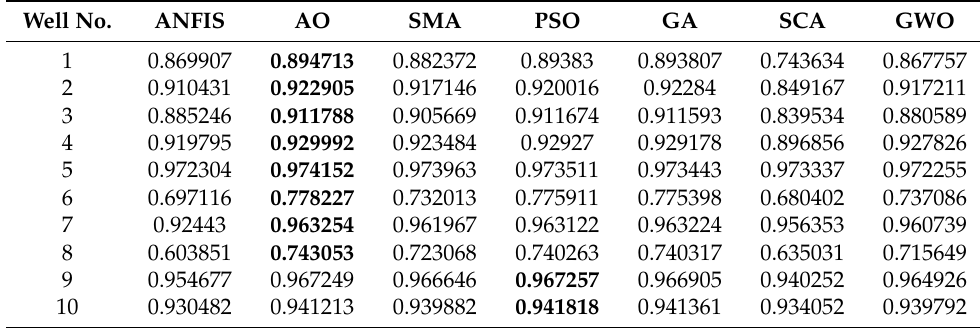
Table 5. The results of the Tahe oilfield, China, in terms of R 2 . The best values are shown in bold. Well No.